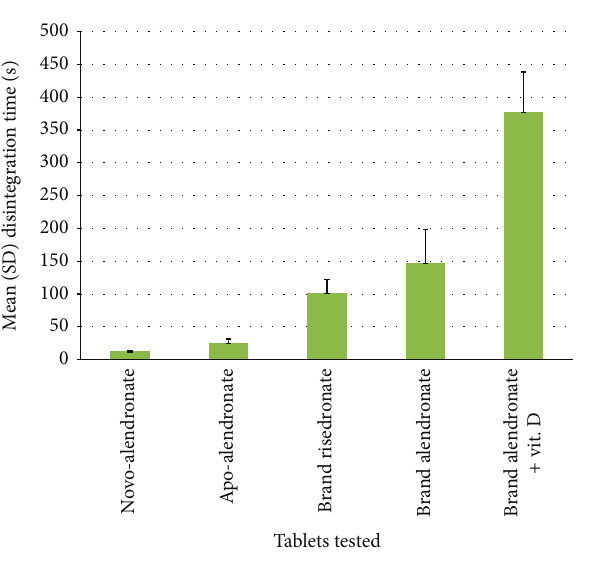
Figure 1: Mean (standard deviation) amino-bisphosphonate tablet disintegration